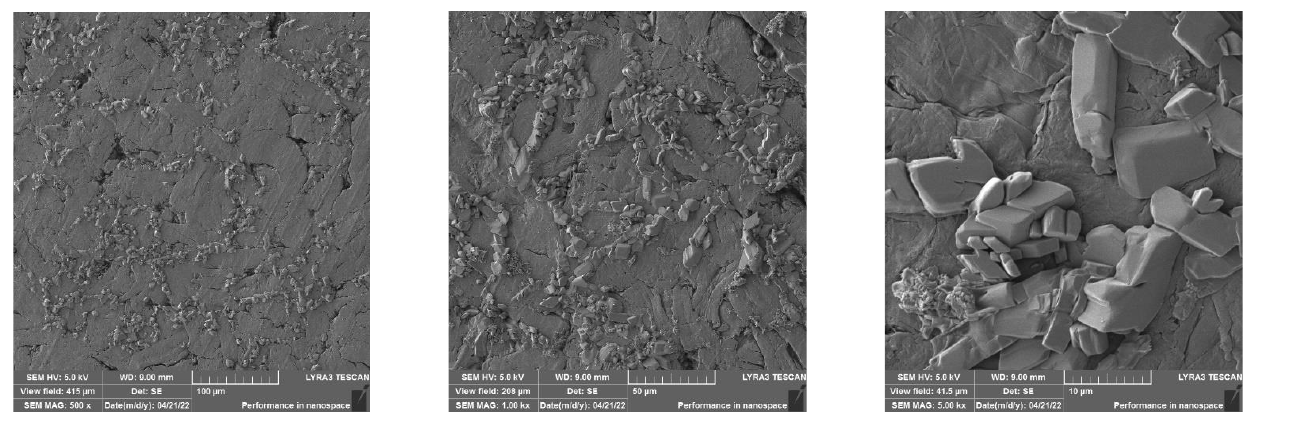
Figure 7. SEM images of tablet surface impregnated by MX in 27 impregnation cycles at 500× ( left ), 1000× ( center ) and 5000× ( right ) magnification.